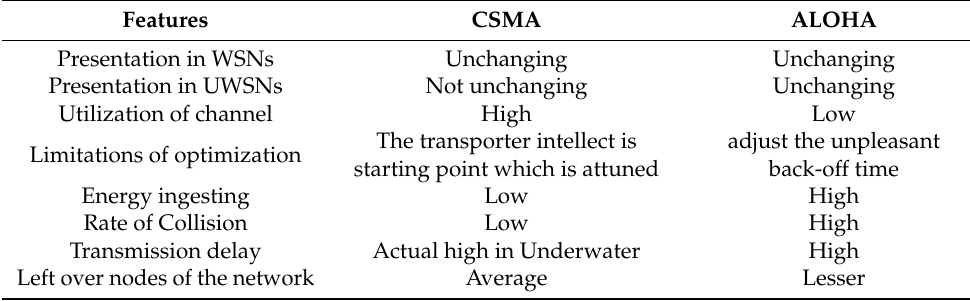
Table 7. The main differences between CSMA and ALOHA